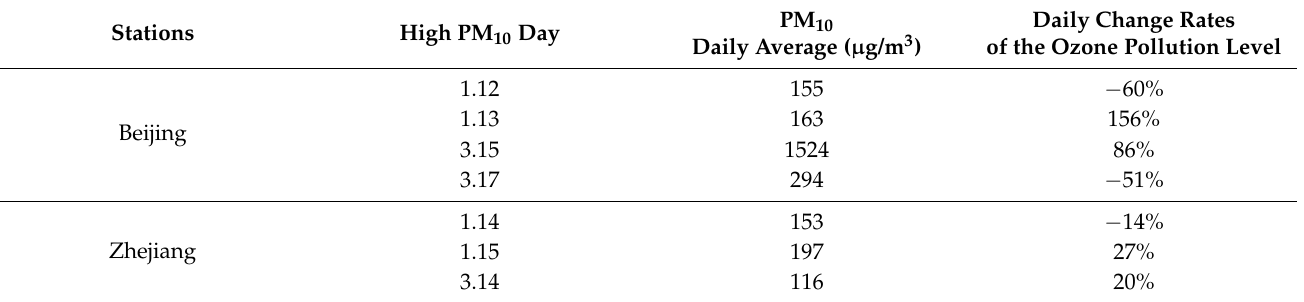
Table 1. Variation of ozone pollution levels in downstream city sites during the 1.12 and 3.15